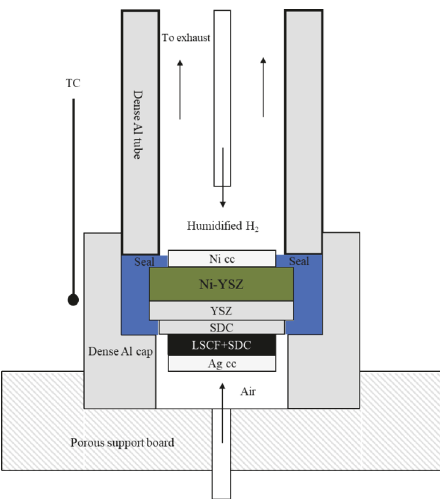
Figure 1: Schematics of the button cell testing setup used for this